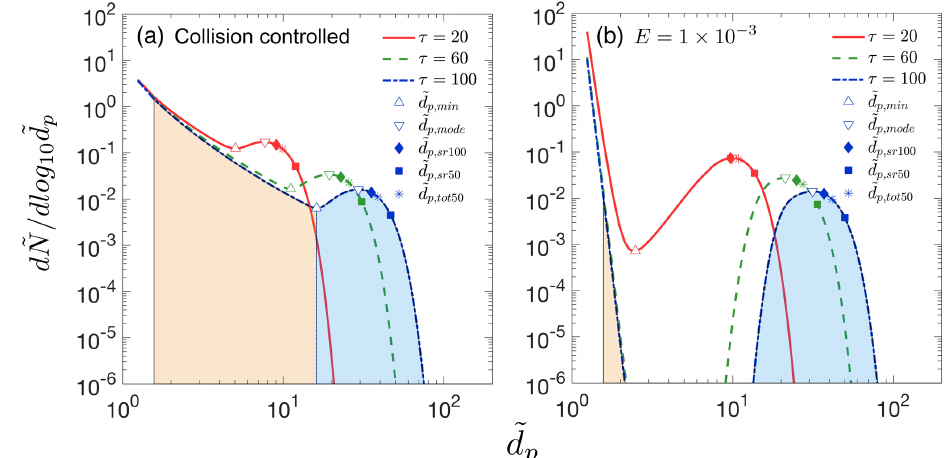
Figure 1. Particle size distributions at dimensionless times τ = 20, 60 and 100 (a) for collision-controlled nucleation ( E = 0) and (b) when evaporation is included with E = 1 × 10 − 3 . Division of the distribution into monomer, cluster and nucleation mode is displayed for τ = 100, with beige and light blue indicating the range of clusters and nucleation mode. Clusters and nucleation mode are separated by e d p , min , where d e N/ dlog 10 e d p is at a local minimum. Characteristic sizes e d p , mode , e d p , sr100 , e d p , sr50 and e d p , tot50 are marked for each time. The relationship between symbols and characteristic sizes is shown only for τ =